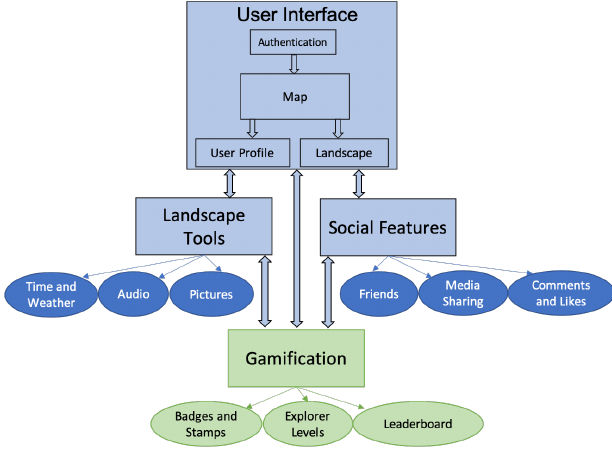
Figure 1. Mobile Application: Main